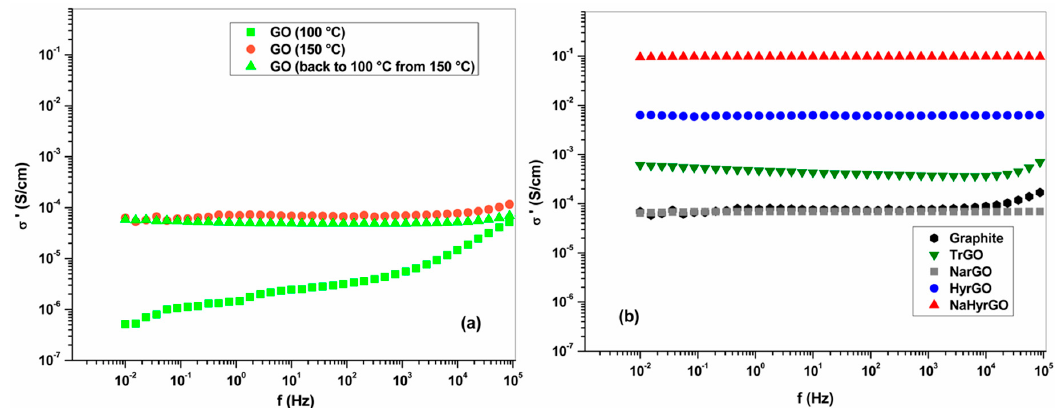
Figure 5. Bulk electrical conductivity of ( a ) GO at 100 and 150 °C, and ( b ) graphite and different rGOs at 150 °C.